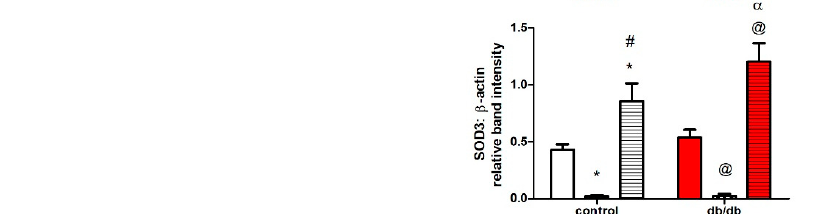
Figure 7. Protein expression of superoxide dismutase (SOD) isoforms in the aortae, as well as carotid and femoral arteries, of db / db (red filling) and control mice (white filling) (16–20 weeks old) ( n = 4). Results are displayed as mean ± SE. Relative band intensities were compared by two-way ANOVA followed by Bonferroni post-test. * denotes p < 0.05 vs. control aorta, # denotes p < 0.05 vs. control femoral, @ denotes p < 0.05 vs. db / db aorta, α denotes p < 0.05 vs. db / db femoral artery. SOD = superoxide dismutase.